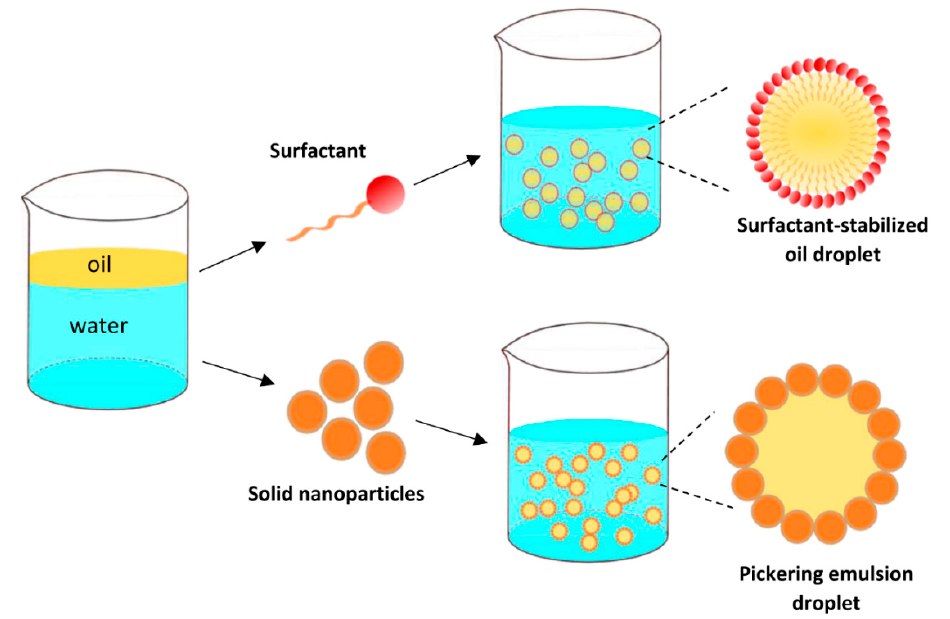
Figure 1. A schematic diagram of surfactant-stabilized and nanoparticles-stabilized oil droplets in an oil-in-water (O / W) emulsion.